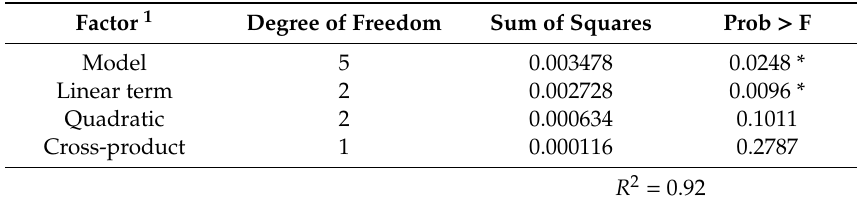
Table 2. ANOVA for substrate concentration pertaining to the response (initial rate).